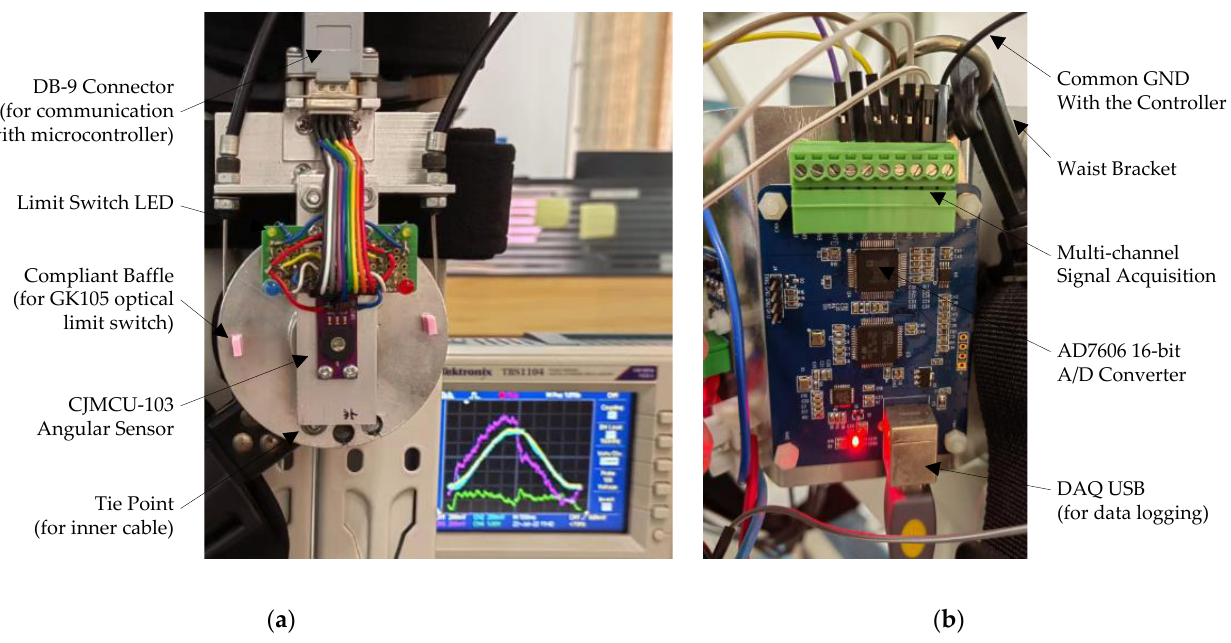
Figure 14. Sensors of the soft exoskeleton knee joint and the associated data-acquisition system.( a ) Sensor system for the knee joint, with the CJMCU-103 rotary potentiometer for measuring the joint angular displacement and GK105 optical switches for limiting the swing angle of shank bracket. shank bracket. ( b ) Multi-channel data-acquisition system based on the 16-bit AD 7606 A/D converter, with the DAQ USB cable connected to the laptop for acquisition configuration and data